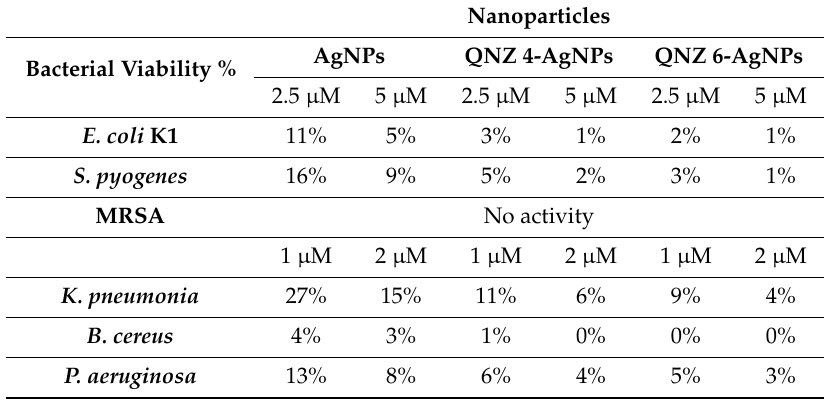
Table 1. Di ff erences in bacterial viability percentages between QNZ nanoconjugate and silver nanoparticles alone.